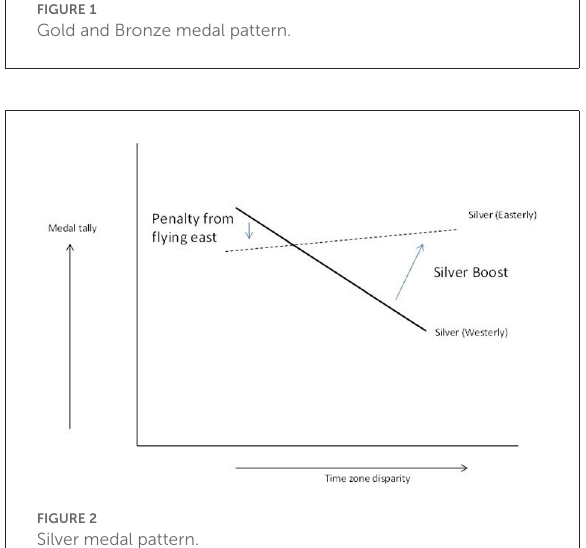
FIGURE2 Silver medal